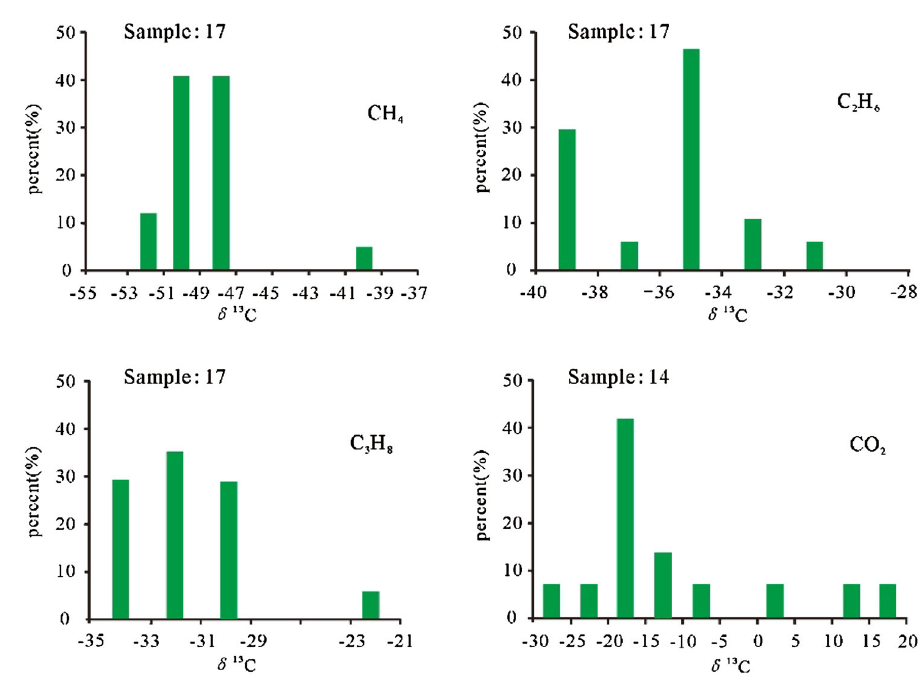
Fig. 4 Graph showing a carbon isotopic frequency comparison of alkane gases and carbon dioxide of gas hydrates